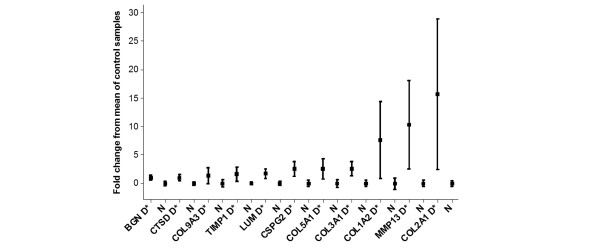
Graph illustrating the means and 95% confidence intervals (CIs) of the gene expression profiles. To normalise values, the mean of each control group has been used to normalise and produce fold changes in expression. The results of the COL9A3 transcript are omitted because the 95% CIs were very high. *Significant difference. BGN, biglycan; COL1A2, type I collagen, alpha two chain; COL2A1, type II collagen alpha 1 chain; COL3A1, type III collagen alpha 1 chain; COL5A1, type V collagen alpha 1 chain; COL9A3, type IX collagen alpha 3 chain; CSPG2, chondroitin sulphate proteoglycan 2; CTSD, cathepsin D; D, disease; LUM, lumican; MMP13, matrix metalloproteinase 13; N, normal; TIMP1, tissue inhibitor of metalloproteinase 1.